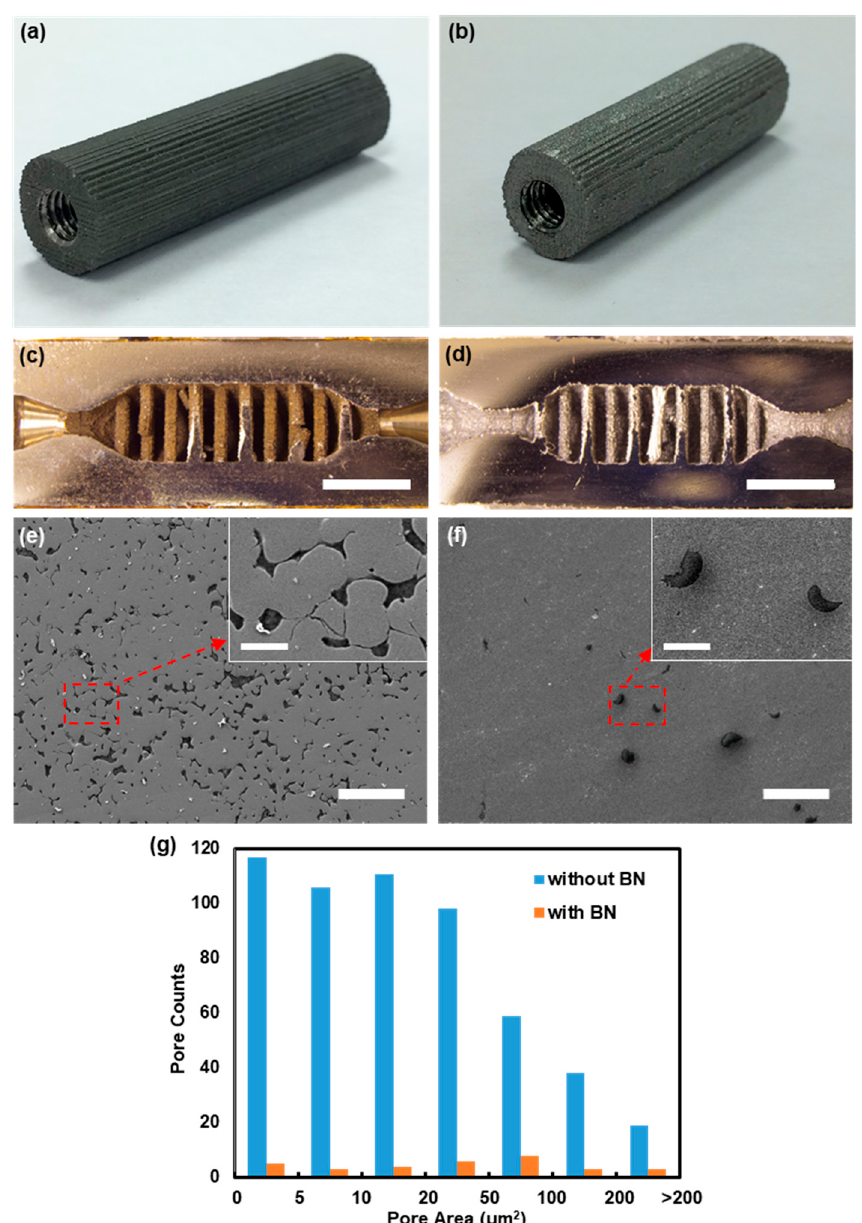
Figure 4. Photographs of the as-sintered preconcentrators (PCs) (10-mm in diameter and 38.68-mm in length) with ( a ) stainless steel (SS) only and ( b ) SS and boron nitride (BN); optical microscope images of the cross-sections of the as-sintered PC with ( c ) SS only and ( d ) SS and BN, scale bar = 5000 µ m; SEM images from the cross-sections of the as-sintered PC with ( e ) SS only and ( f ) SS and BN, scale bar = 100 µ m, (inset) zoomed-in images of the red-marked area, scale bar = 10 µ m; ( g ) histogram of pore areas in the images ( e ) and ( f ).